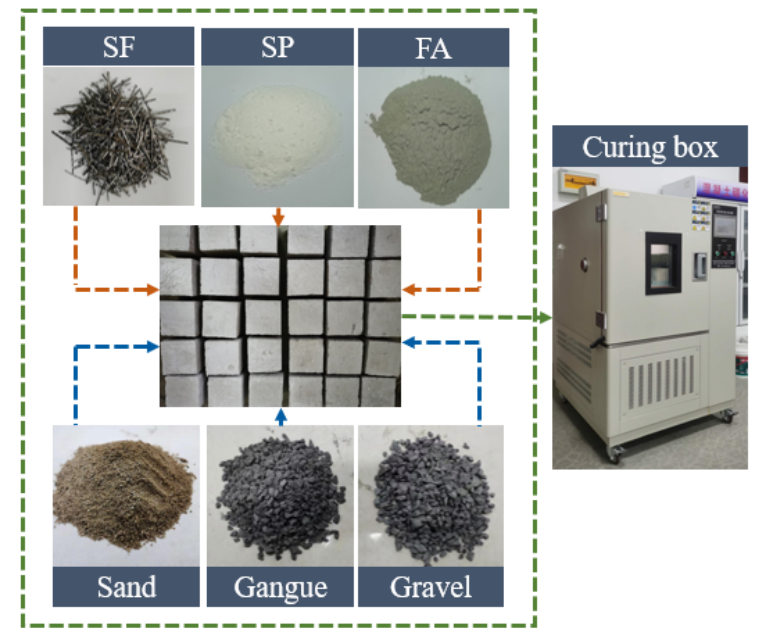
Figure 4. Experimental materials and maintenance.